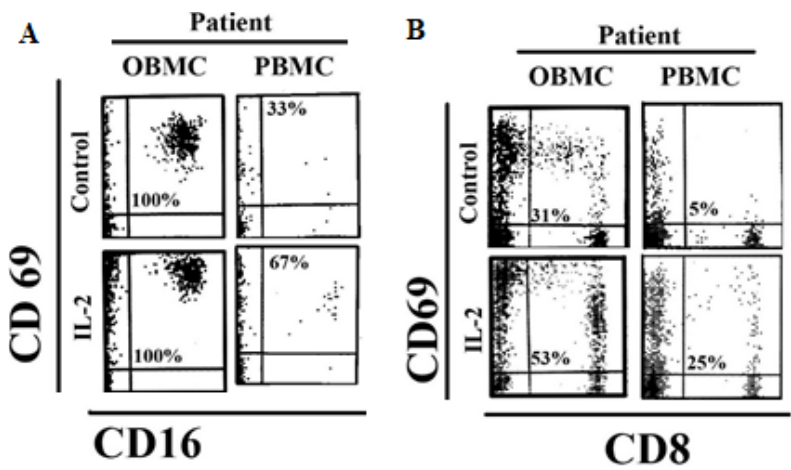
Figure 1. Increased activation of NK and CD8 + T cells in oral blood when compared to peripheral blood of periodontitis patients. Mononuclear cells (1 × 10 6 /mL) obtained from oral and peripheral blood of periodontitis patients left untreated and treated with IL-2 (500 U/mL) for 18–24 h after which they were washed twice. The surface expression levels of CD16 and CD69 ( A ), and CD8 and CD69 ( B ) were determined using flow cytometry. IgG2 isotype was used as controls. Numbers in each quadrant represent the percentages of stained sub-population for the specific antigen. The oral and peripheral blood was obtained from the same donors. One of four representative experiments is shown in this figure.